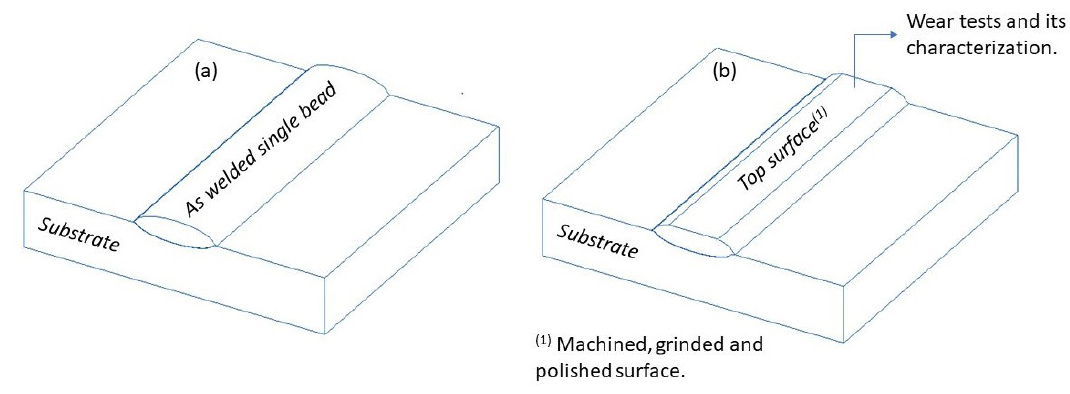
Figure 2. Schematic view of the as-deposited single bead (a) and the machined top surface (b).